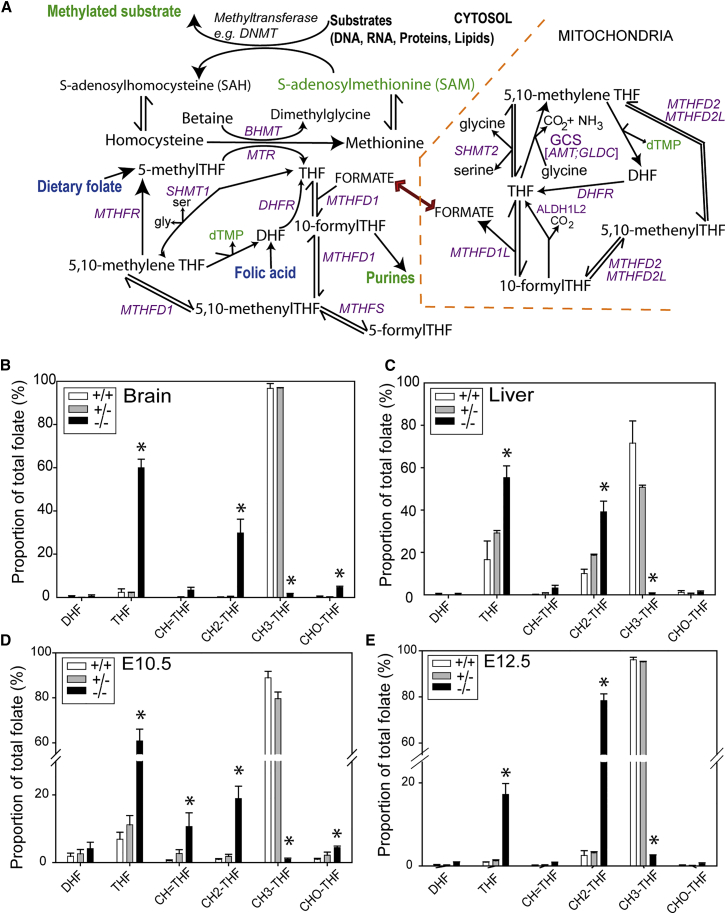
Altered Abundance of Folates in Mthfr-Null Embryos(A) Summary diagram of folate 1C metabolism (enzymes are indicated in purple text).(B–E) LC-MS/MS profiling of folates in (B) post-natal brain, (C) post-natal liver, and embryos at E10.5 (D) and E12.5 (E) shows that the relative abundance of 5-methyl THF (CH3THF) is significantly reduced in Mthfr−/− (∗p < 0.0001 compared with Mthfr+/+). Conversely, the abundance of other folates was increased (∗p < 0.01, ∗∗p < 0.05; significant difference from wild-type, p < 0.05). Note that CH2-THF may be under-represented because of conversion to THF during analysis (maximal 20% of CH2-THF at pH 7 used). Number of samples, n = 3 per genotype for brain, liver, and E12.5. At E10.5, n = 4 Mthfr+/+, 7 Mthfr+/−, and 5 Mthfr−/−.See also Figure S1 and Table S1.